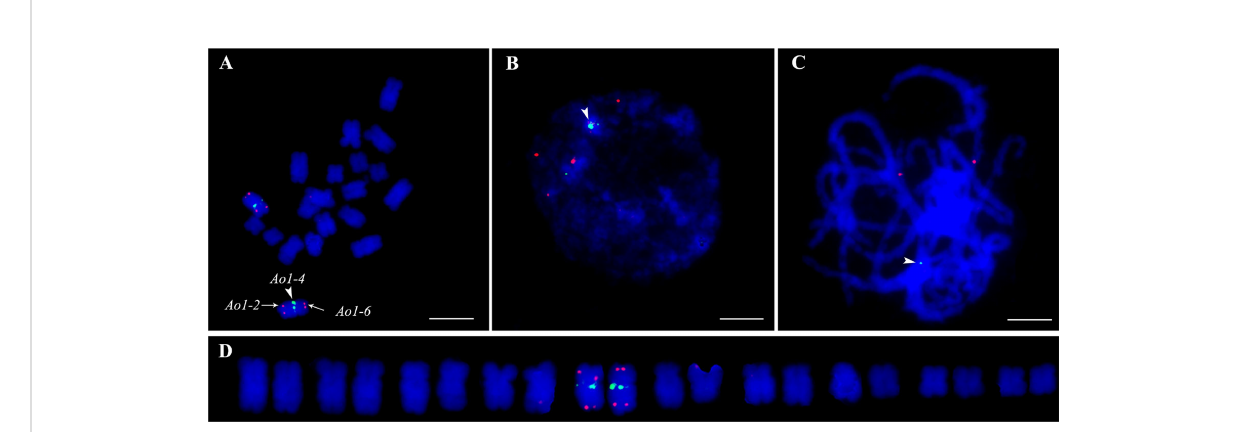
FIGURE 2 Accuracy validation of single copy gene-based FISH protocol in garden asparagus using three gene probe cocktail. The probes corresponding to Ao1-2 , Ao1-4 , and Ao1-6 genes, which are all located on chromosome 5, were co-hybridized onto chromosome 5 at metaphase (A) , interphase (B) , and meiotic pachytene (C, D) Karyotypic analysis. The red signals of the Ao1-2 and Ao1-6 probes are at the end of the long and short arms of chromosome 5, respectively, whereas the green signals of the Ao1-4 probe are at the centromeres of chromosome 5. Scale bar = 10 m